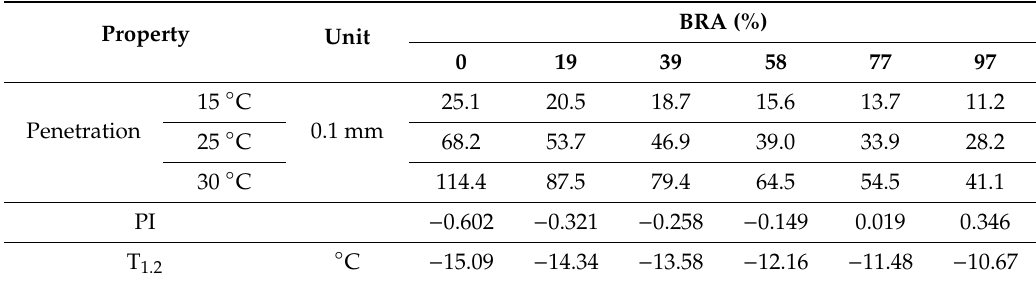
Table 6. Test results of BRA-modified